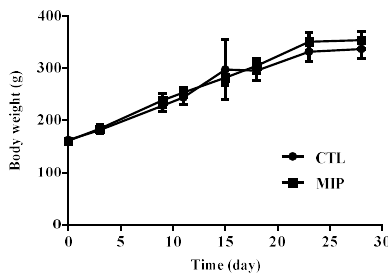
Figure 7. Body weight of rats after 28 day sub-aute oral toxicity testing with MIPs. CTL: control; MIP: mesoporous iron particles. All data are presented as mean ± SD ( n = 10). Table 1. Hematology values of rats after 28 day sub-acute oral toxicity experiment with MIPs.